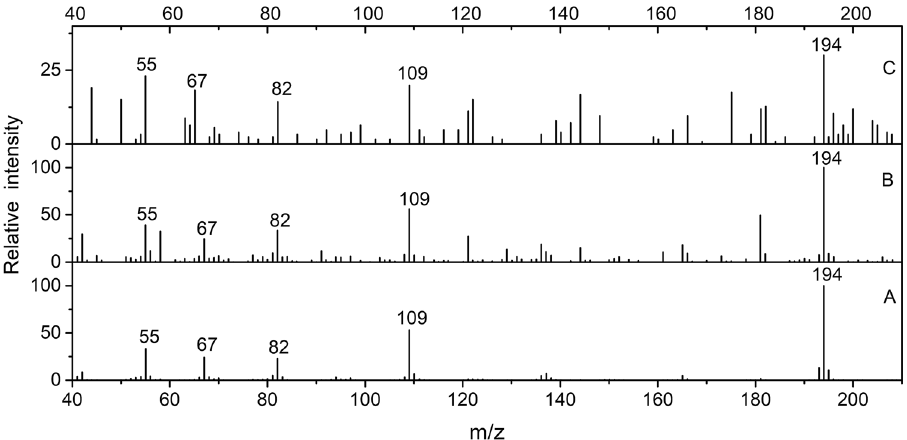
Figure 6. The mass spectrum of caffeine (peak 5 in Fig. 5) of A—modern tea; B—modern tea residue; C— sample CST by THM Py-GC/MS analysis.